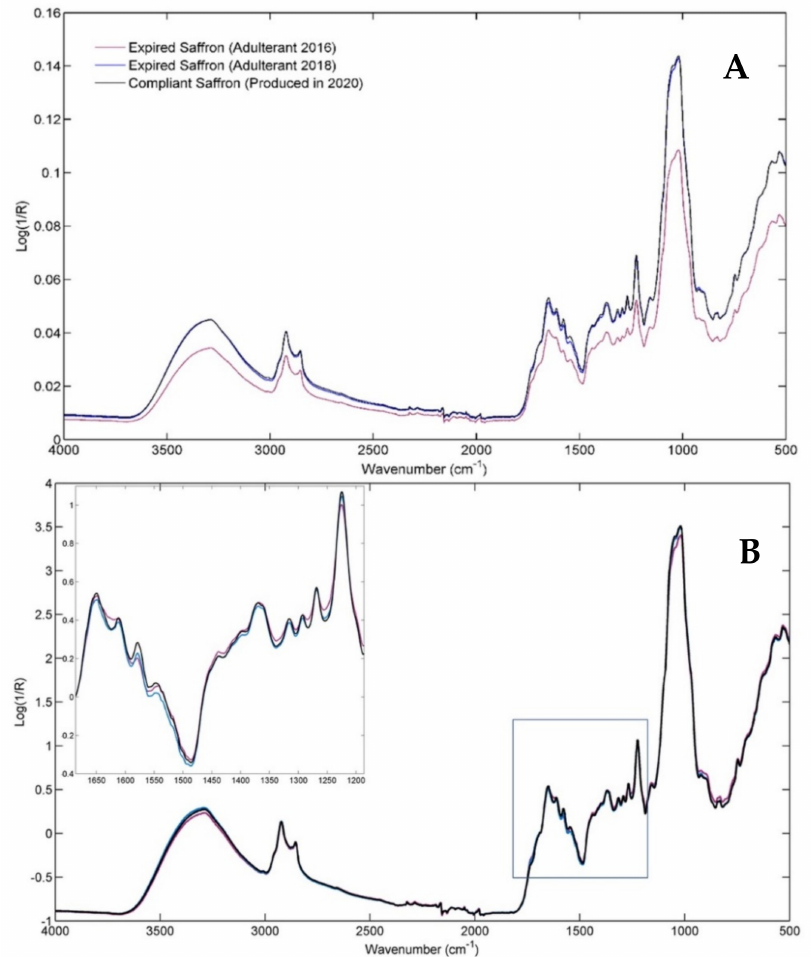
Figure 1. ( A ) Mean row infrared spectra for the Compliant class (in black) and for the two considered pure Adulterants, i.e., Adulterant 2016 (in purple) and Adulterant 2018 (in blue). ( B ) Mean signals for the SNV-pre-processed spectra, distinguished again according to the three